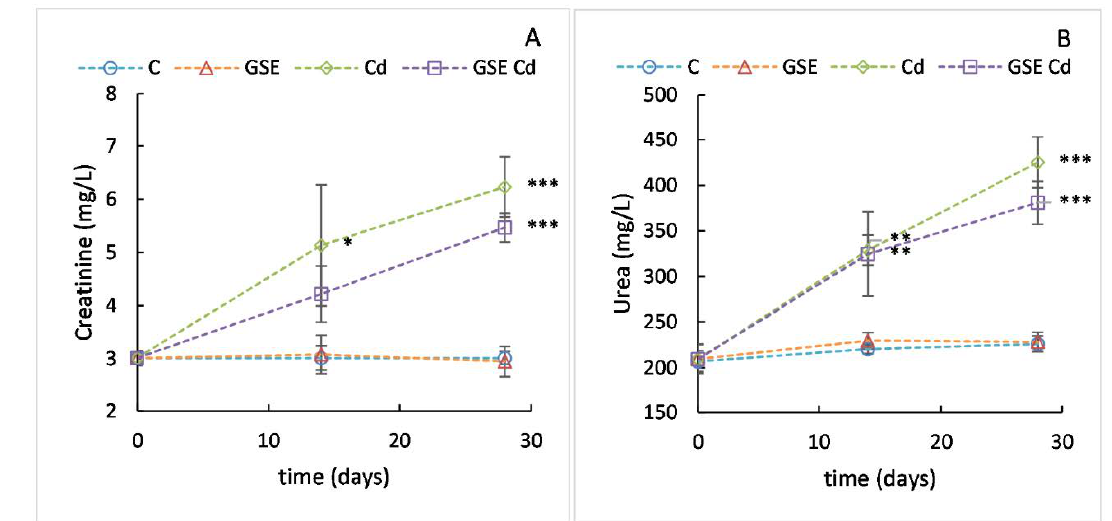
Figure 2. Plasma creatinine ( A ) and urea ( B ) values for the control variant (blue line with circles), the variant with GSE addition (orange line with triangles), the variant with Cd addition (green line with diamonds), and the variant with both GSE and Cd addition (violet line with squares) on days 0, 14, and 28 of monitoring. Data are presented as means ± sd from three replicates. Data were analyzed by one-way ANOVA (each time point separately) and differences from control are marked: * indicates p ≤ 0.05, ** indicates p ≤ 0.01, *** indicates p ≤